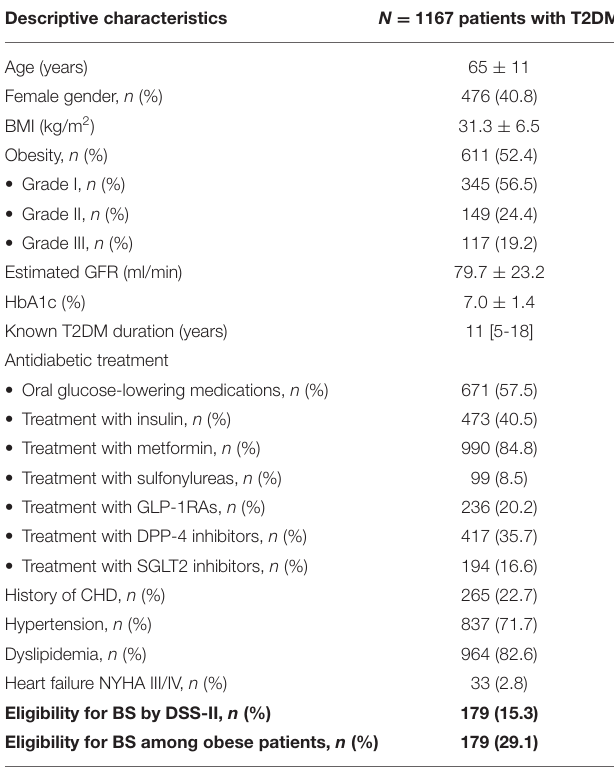
TABLE 1 | Demographic, anthropometric and clinical characteristics of the study